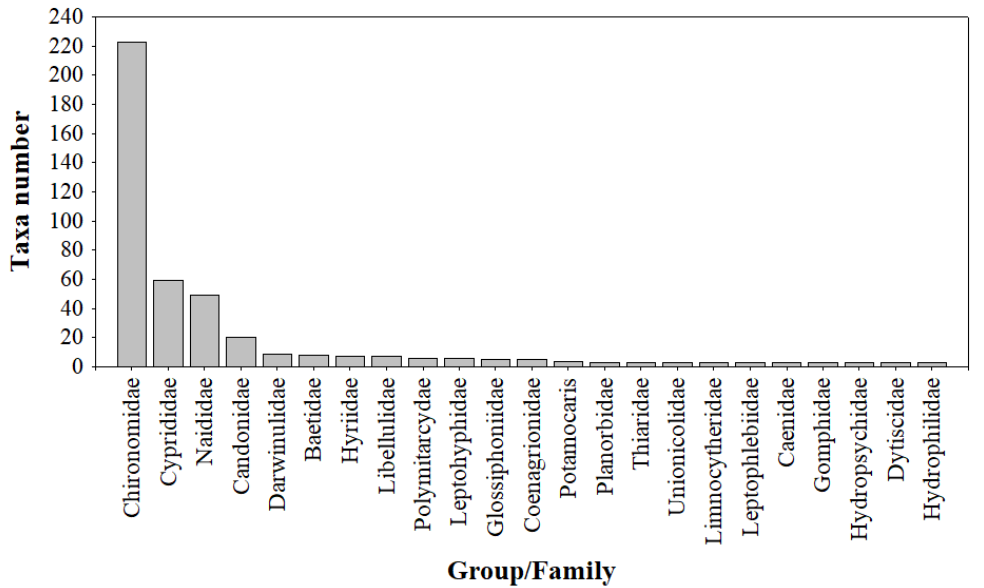
Figure 4. Number of taxa per group/family recorded in the upper Paraná River Floodplain through the revised period.